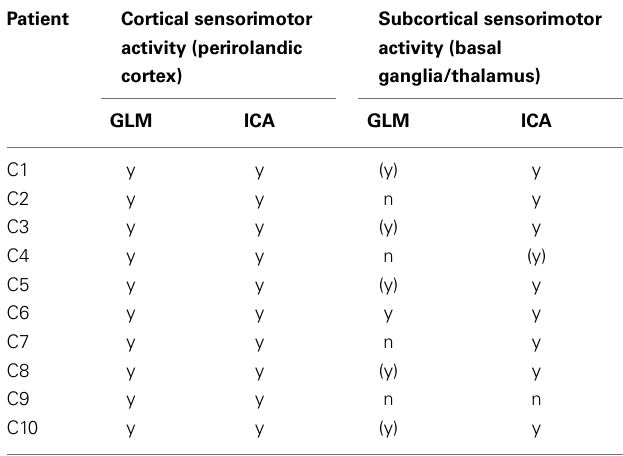
Table 2 |A comparison of the ability of the GLM and ICA to detect activation in cortical and subcortical sensorimotor areas in the chin